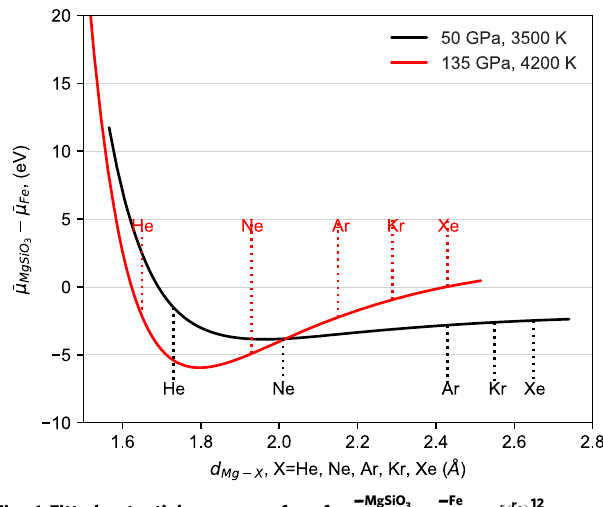
Fig. 6 Fitted potential energy surface for -- (cid:1) 2 ð r 0 Þ 6 (cid:4) (cid:1) μ Fe , X = He, Ne, Ar, Kr, Xe. X ‘ substitutes ’ one O atom in r X [MgO n ] cluster and the size mismatch between O and X dominates the change in energy, while the chemical contribution is